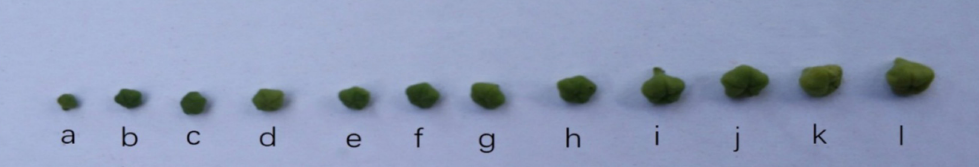
Figure 4. Morphological characteristics of different flower size of ‘Maya’